Question: Summarize what this figure shows in one sentence.
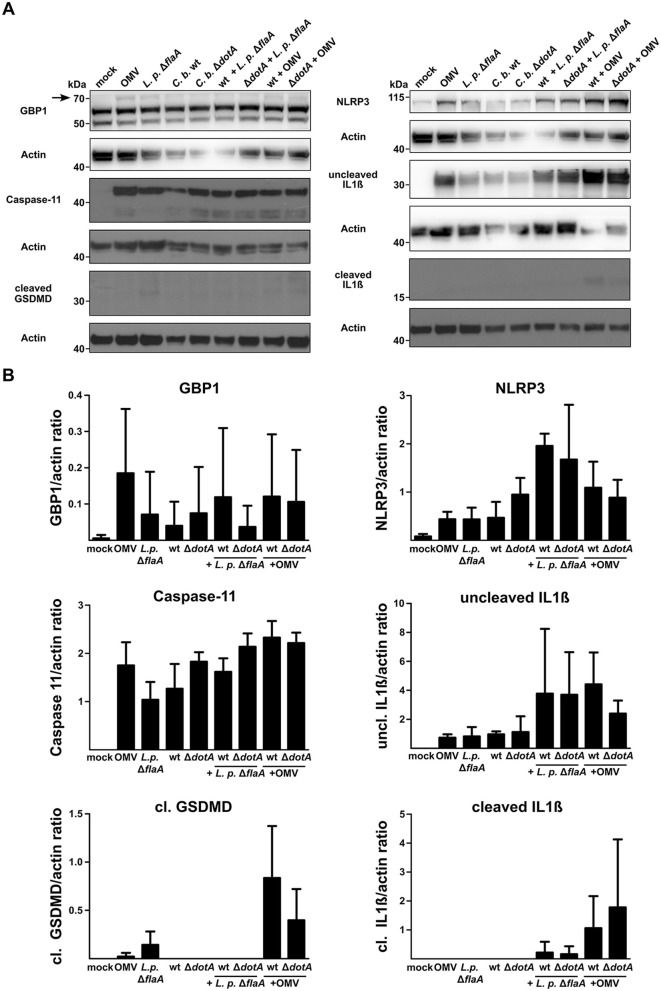
Answer: Inflammasome activation is strongly reduced under hypoxic conditions. BMDM were stimulated with OMVs (2 µg/ml) for 8h, infected with L. pneumophila Δ flaA for 8h, infected with C. burnetii wt or Δ dotA for 32h or infected with C. burnetii wt or Δ dotA for 24h with subsequent infection with L. pneumophila Δ flaA or stimulation with OMVs for 8h under hypoxic conditions (0.5% O 2 ). Immunoblot analysis was performed using antibodies against GBP1, caspase 11, cleaved GSDMD, NLRP3, uncleaved IL1β, cleaved IL1β, and actin as loading control. (A) One representative blot from at least four independent experiments is shown for each target. Importantly, the same membrane was used to analyze the expression of GBP1 and NLRP3. Therefore, the same actin blot was used as loading control for both proteins. (B) Densitometirc analysis of the protein of interest to actin ratios was performed from at least three independent experiments using ImageJ.